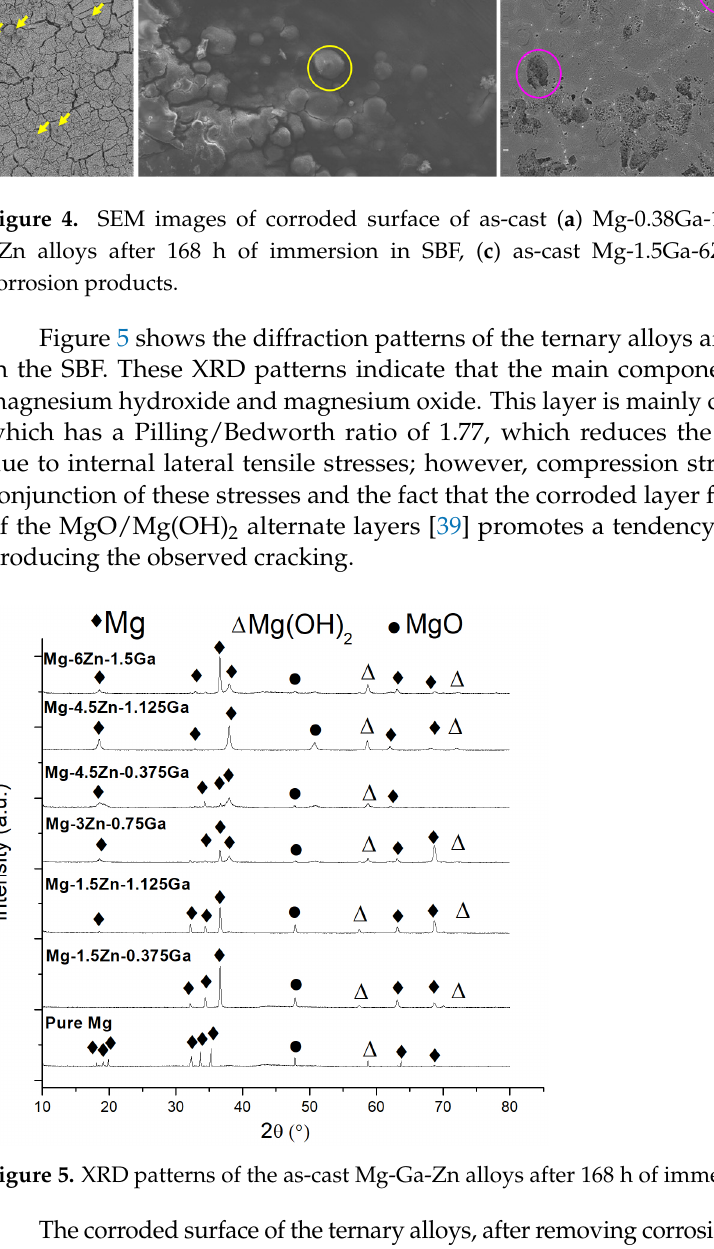
Figure 6. All the alloys show localized corrosion, and the corrosion behavior is clear: